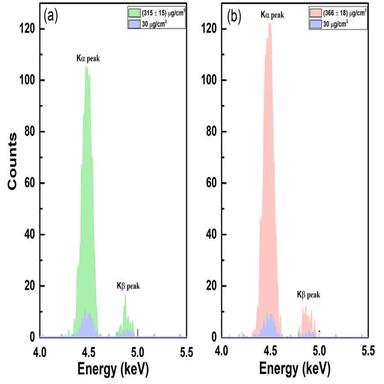
Spectra of two samples of 48Ti using EDXRF technique showing the obtained target thickness.